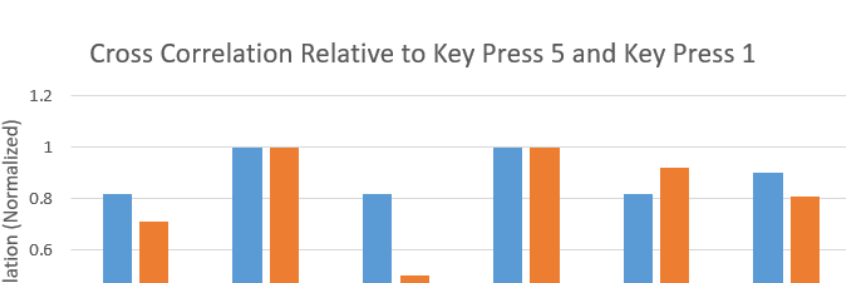
Figure 8. Similarity of press and release of key “6” with key “8”.